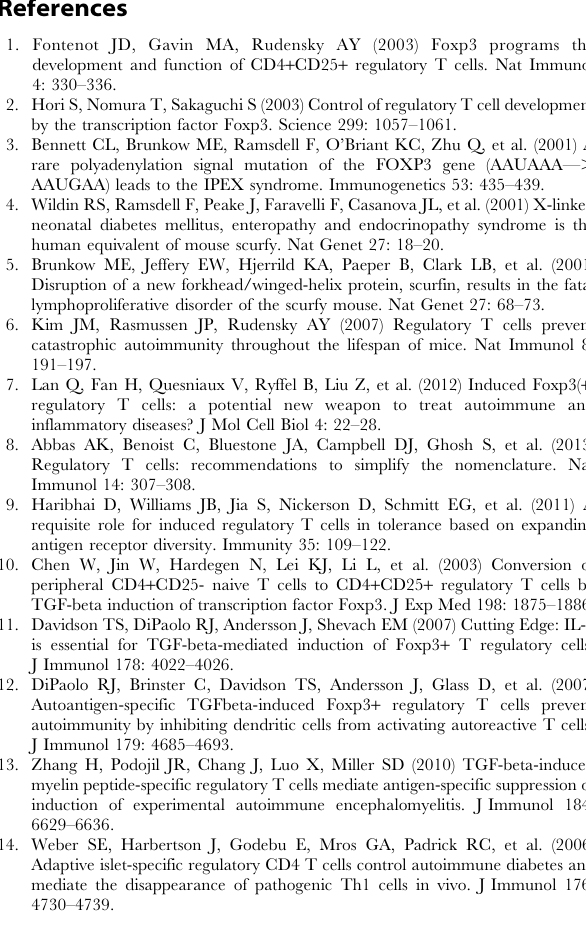
transfer into TxA23 mice (black line). Data represents 2 independent experiments. (TIF) Figure S3 Comparison of cytokines and transcription factors expressed by enTregs and iTregs. mRNA was isolated from enTregs and iTregs that were transferred into TxA23 mice, analyzed by qRT-PCR and normalized to mRNA isolated from CD4 + Foxp3 - T cells from BALB/c mice. (A) Comparison of expression levels of Il10 , Gata3 , and Blimp1 . Data shown as mean 6 SEM from 4-6 independent experiments and analyzed using a Mann–Whitney U test. * p , 0.05, NS =not significant.